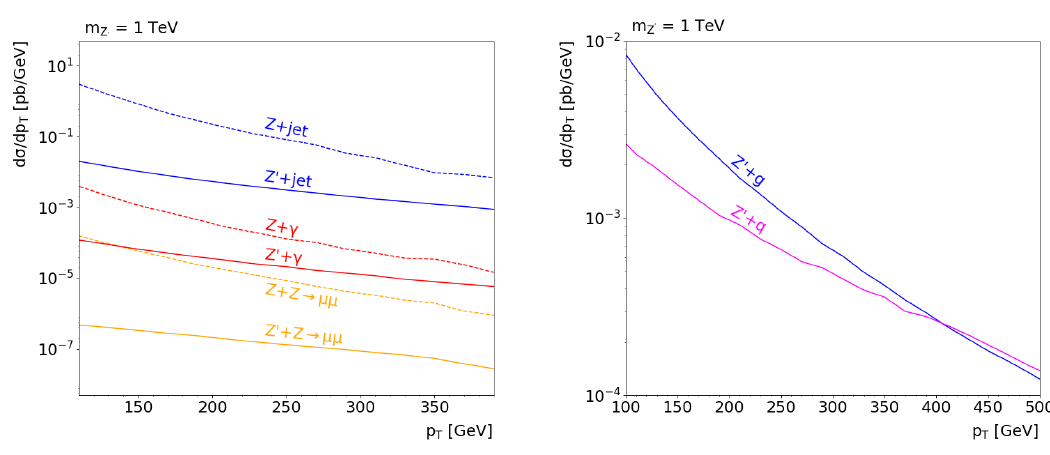
Figure 2: Transverse momentum spectrum for different mono- X signals and back- grounds assuming a heavy vector mediator (left). The spectrum for the jet is com- posed by a q q initial state with a final state gluon and a quark gluon initial state with a quark jet radiated (right), here decomposed into fractions of the total signal.